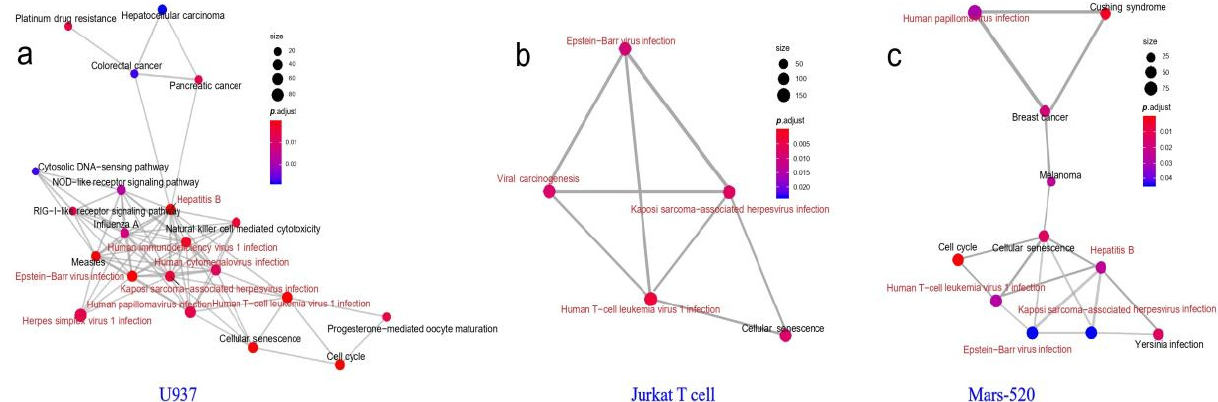
Figure 6. The clustering results of significantly enriched KEGG pathways. The KEGG enrichment results of data of human U937 cells ( a ), human Jurkat T cells ( b ) and Mars 520 ( c ), were clustered according to the overlap degree of differential genes. The node size in the figure is determined by the number of genes enriched in the corresponding pathway; the color changes in the figure are determined by adjusting the p ‐ value, which is the false discovery rate provided by the KEGG en ‐ richment tool; lines in the network represent there were overlapping genes in the two connected pathways, and thicker lines represent more overlapping genes in the two pathways.